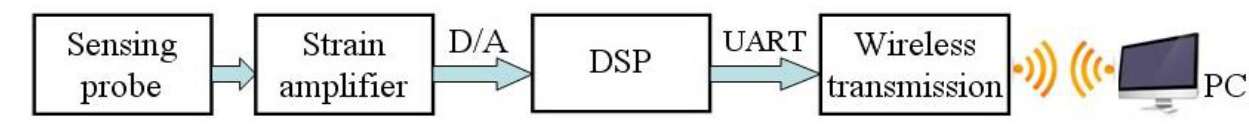
Figure 2. Wireless fatigue monitoring system.